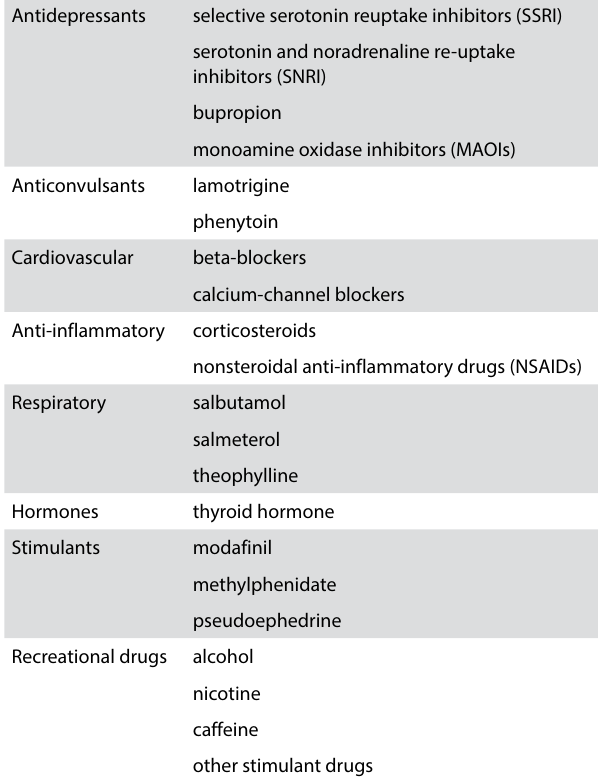
Table I: Potential causes of drug-induced insomnia Antidepressants selective serotonin reuptake inhibitors